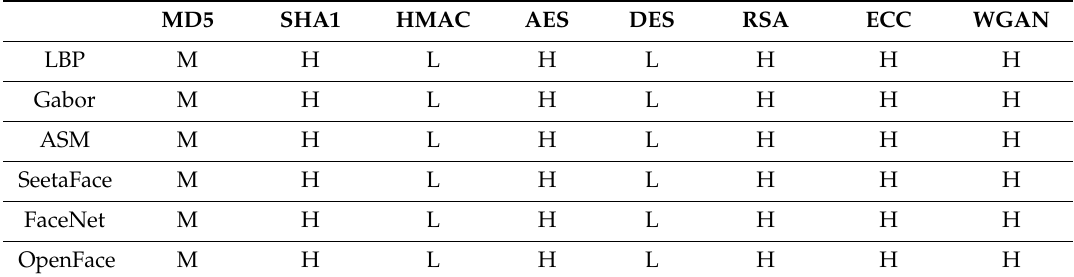
Table 5. Deciphering complexity analysis (L, Low; M, Medium; H, High).